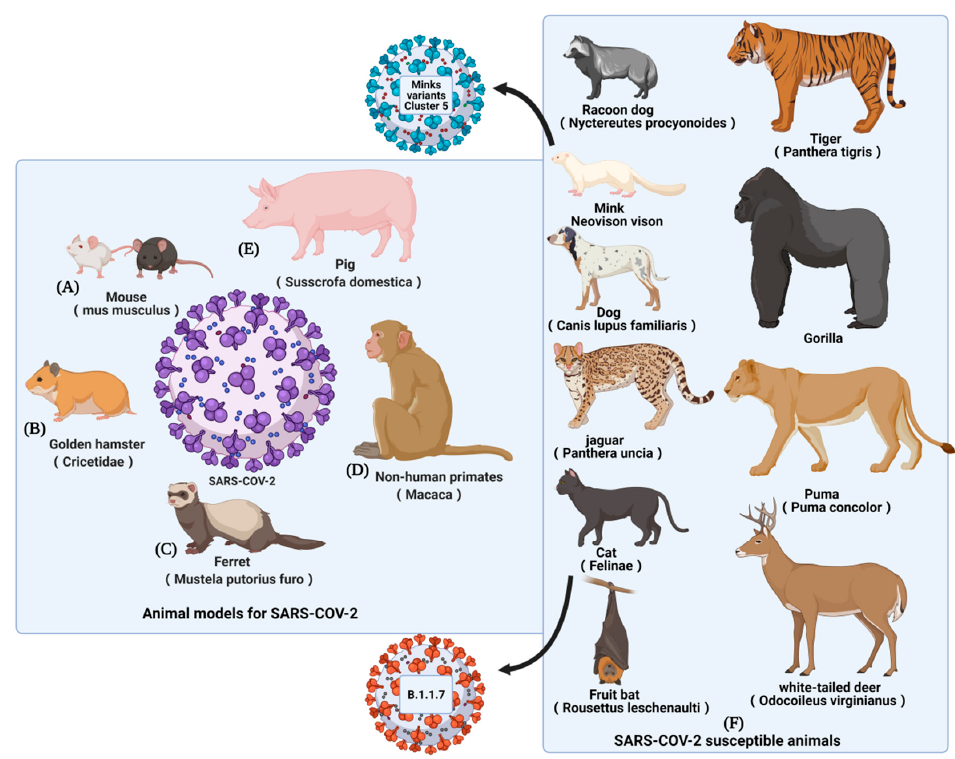
Figure 1. COVID-19 animal models and susceptible animals. ( A ) Mouse models: hACE2 transgenic mouse, hACE2-transdued mouse, and mouse-adapted SARS-CoV-2. ( B ) Golden hamster model. ( C ) Ferret model. ( D ) No human primates: Rhesus macaque model and Cynomolgus macaque model. ( E ) Pig model. ( F ) Other susceptible animals.